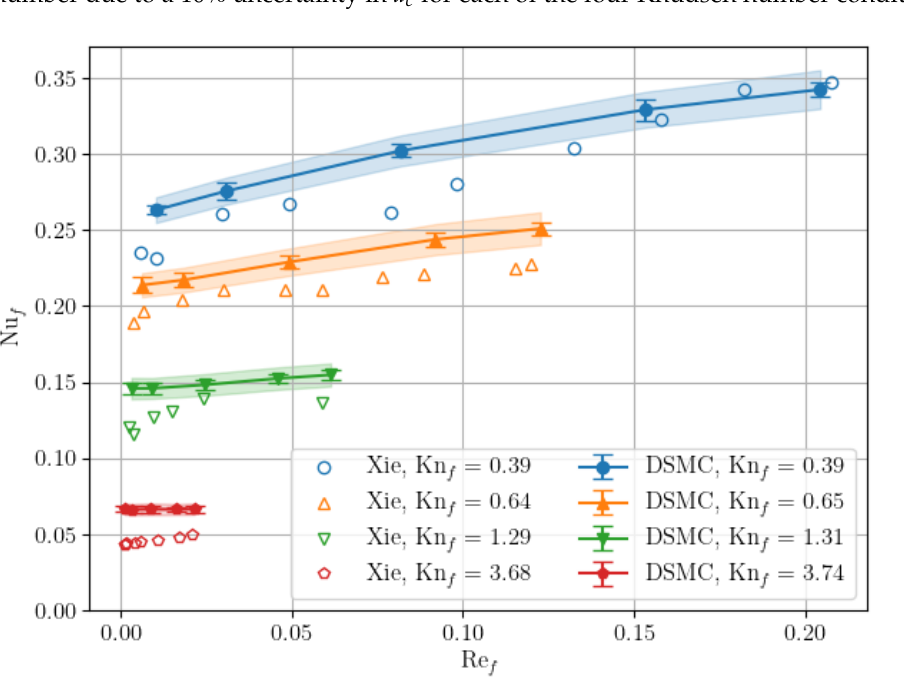
Figure 9. Comparison between DSMC results and experimental data [6]. Error bars indicate ± 1 σ of the steady-state DSMC data. Shaded regions are predicted uncertainty bounds in the DSMC results due to a ± 10% uncertainty in surface accommodation coefficient a c . Table 3. Average uncertainty in DSMC Nu f due to a 10% uncertainty in a c for the four different Knudsen cases seen in Figure